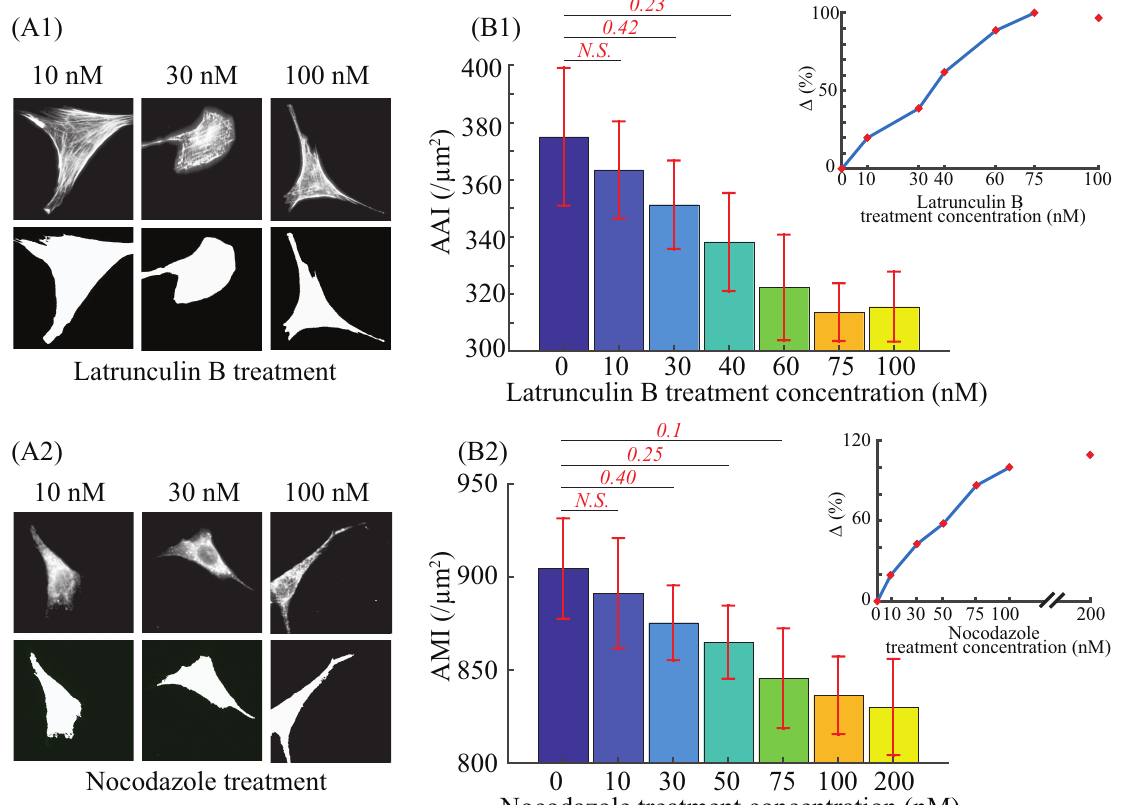
Figure 3. Example F-actin and microtubule images of cells treated with ( A1 ) latrunculin B and ( A2 ) nocodazole, respectively, together with their corresponding detected cell area (lower rows, respectively). ( B1 , B2 ) are the AAI and the AMI together with their corresponding relative change ∆ , respectively. The error bars represent the standard errors. n = 50. Student’s t -test was performed to analyze the statistical difference: for each treatment concentration, data were compared with respect to the untreated ones. A p < 0.05 was yielded for each comparison, unless otherwise denoted in the figure (with p values in red bold italic